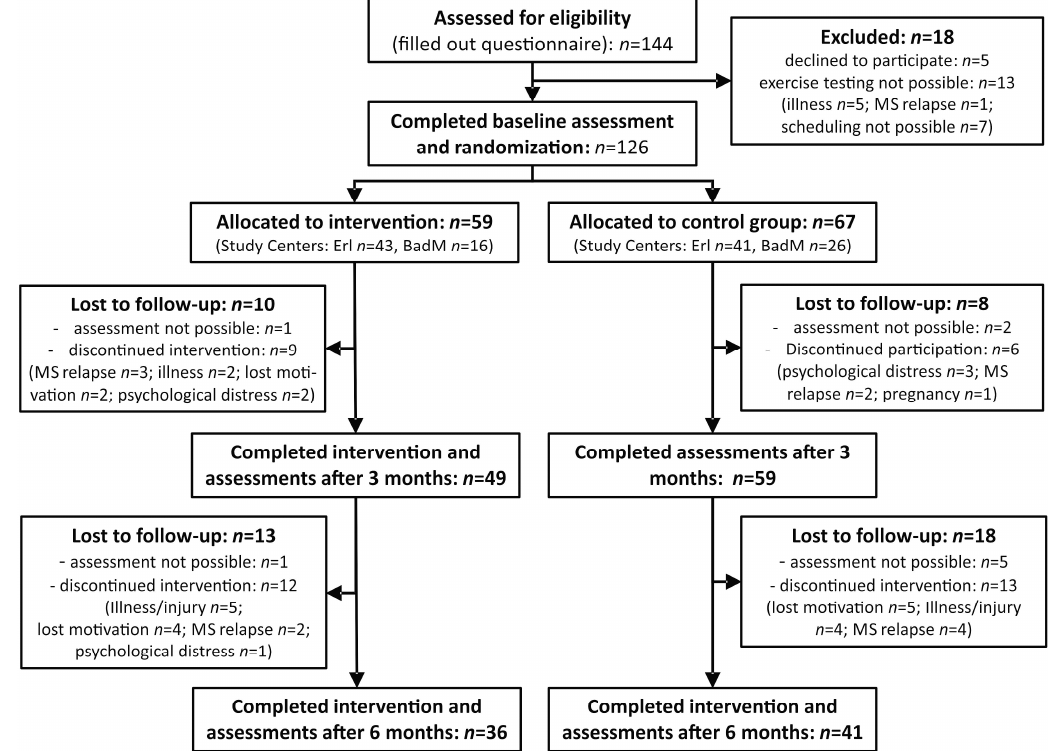
Figure 1. Flowchart of the study (study centres: Erl—Erlangen, BadM—Bad Mergentheim). Table 1 characterizes the sample at baseline. For the measured outcomes, significant baseline differences between intervention and control groups were only found for peak expiratory flow ( p = 0.01). No differences were found for HrQoL ( p = 0.462), fatigue ( p = 0.407), aerobic fitness ( p = 0.864), forced